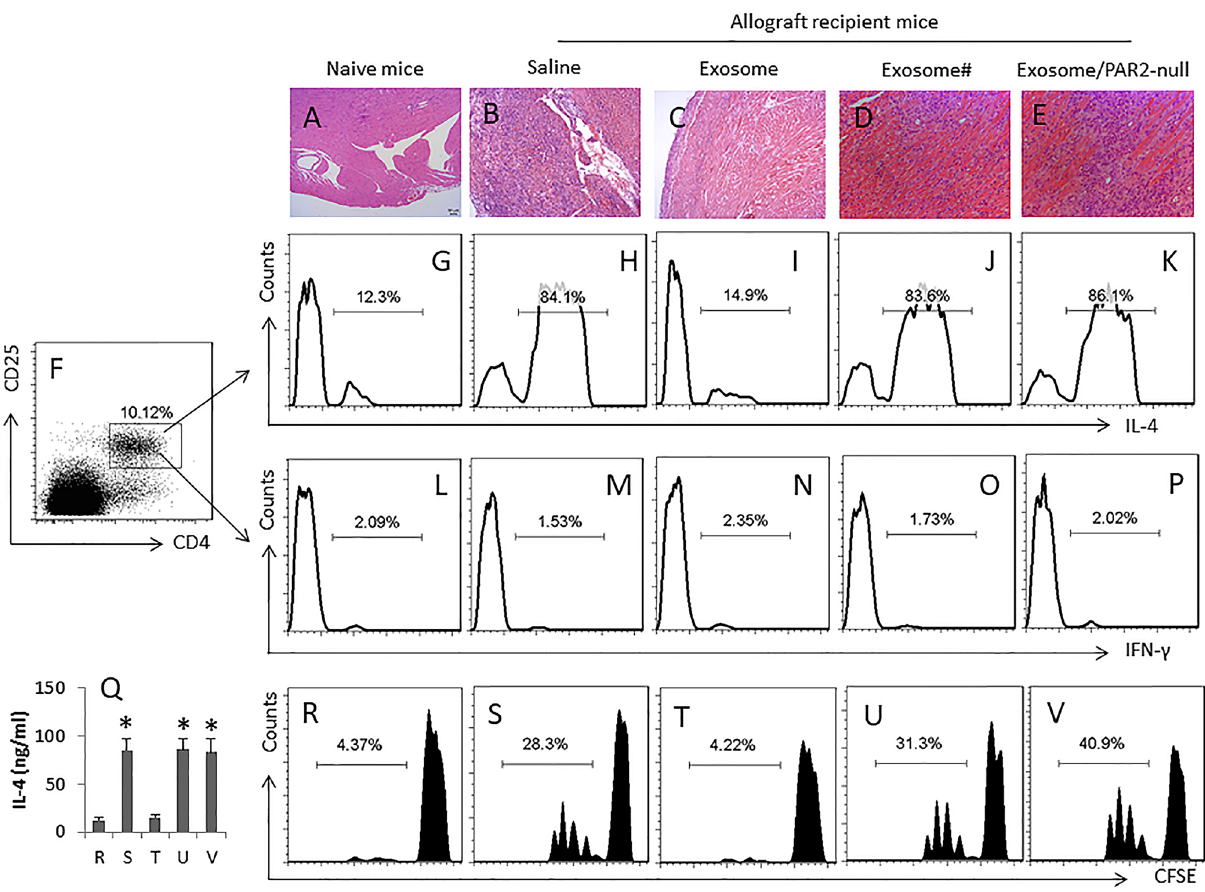
Figure 1. A correct version of the original Figure